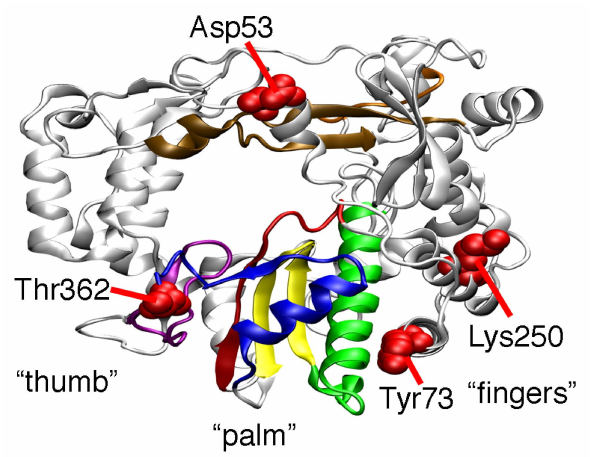
Figure 1. Locations of the amino acid substitutions in the Sabin I polymerase. The structure of the PV RdRp (PDB 1RA6 [33]) has fingers, palm, and thumb subdomains. Shown here is the “backside” of the protein, which allows easier visualization of the Sabin residues. The conserved structural motifs are colored (A, red; B, green; C, yellow; D, blue; E, purple; F, orange; G, brown). The locations of the amino acid residues changed in the Sabin I polymerase are indicated in red ( i.e. , D53N, Y73H, K250E, and